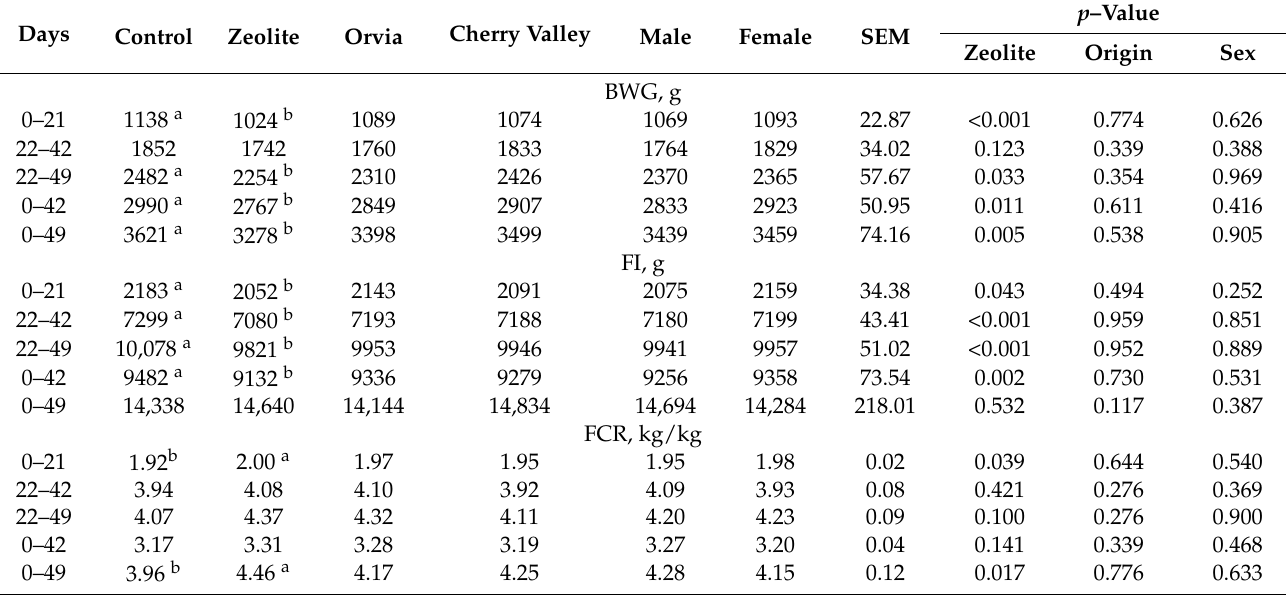
Table 3. Growth performance of broiler